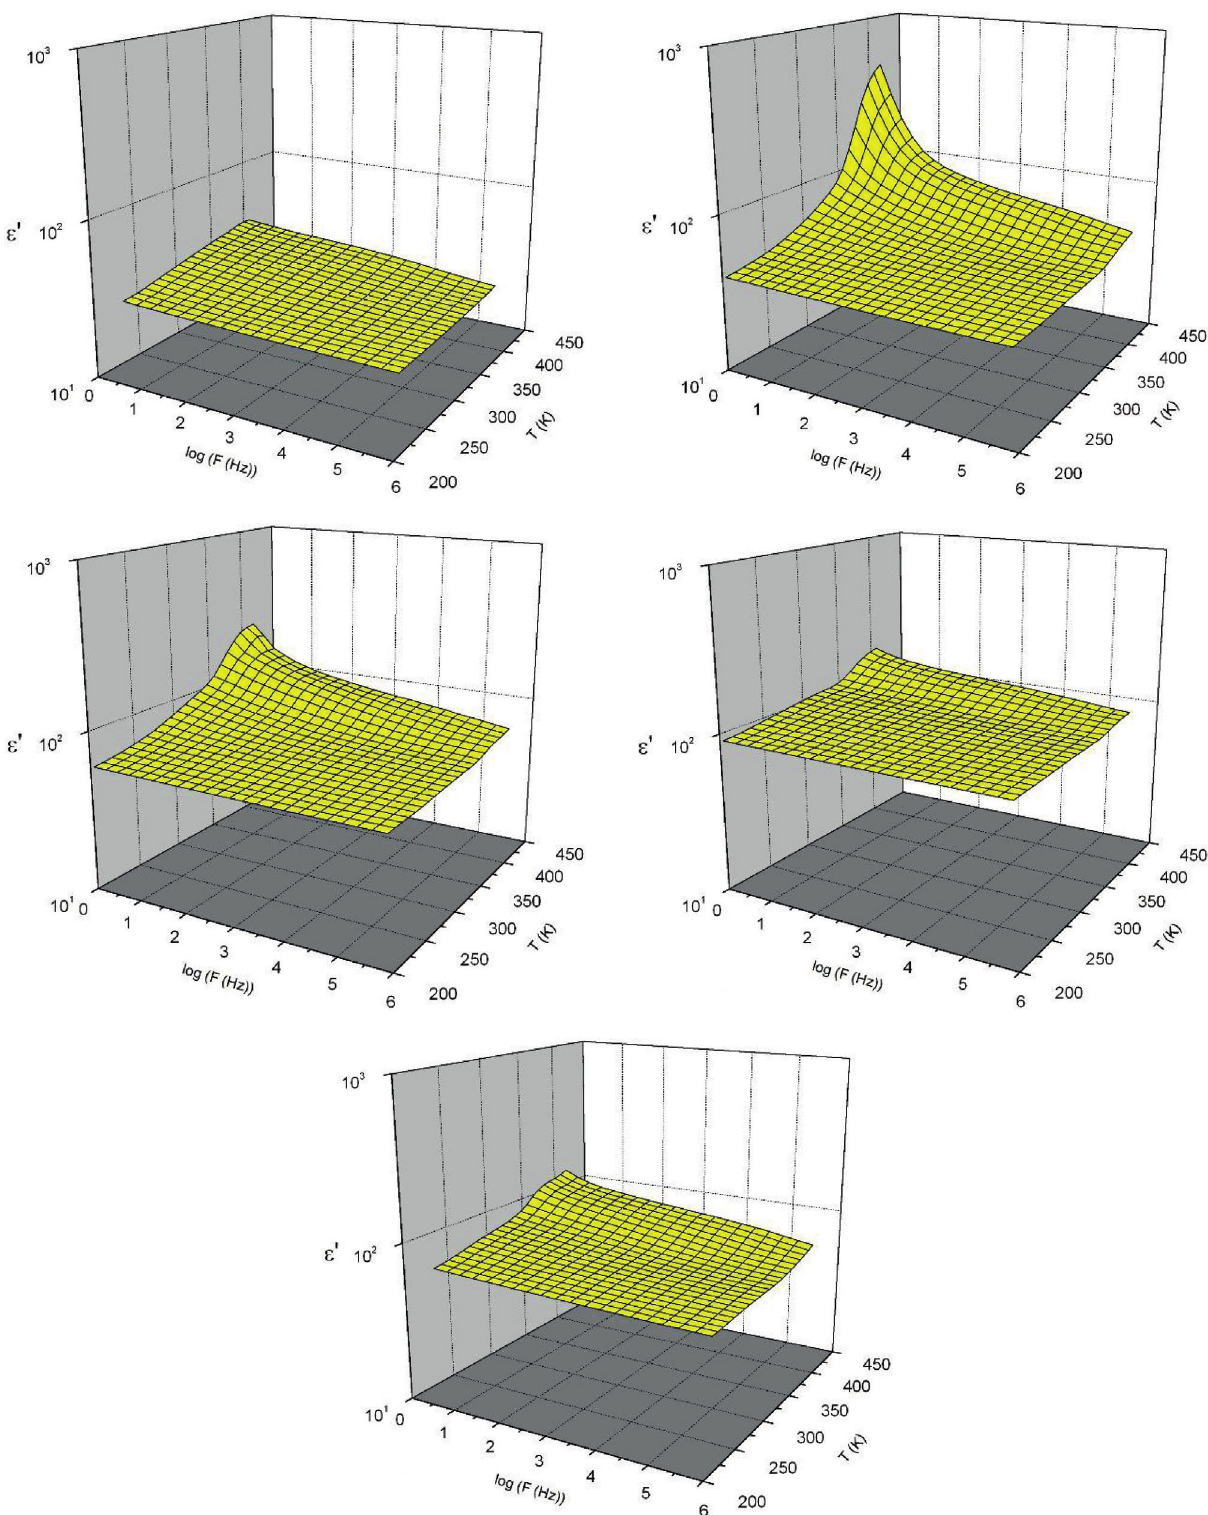
Fig. 1: The variation of e ′ with frequency and temperature for the samples x = 0, 0.25, 0.50, 0.75, 1.00 respectively from top to